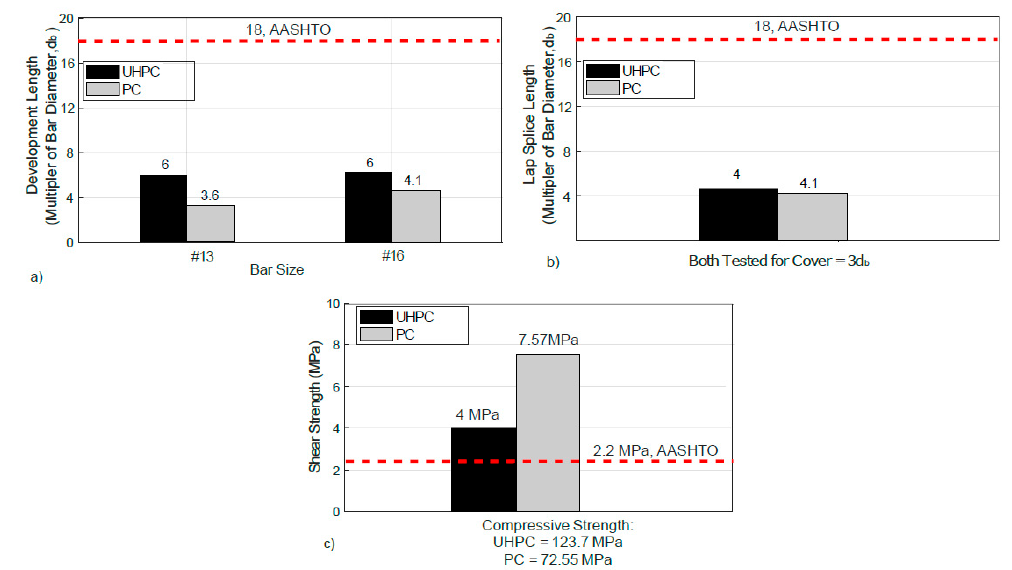
Figure 11. Test result comparison between PC and UHPC: ( a ) development length; ( b ) lap splice length; ( c ) shear strength.